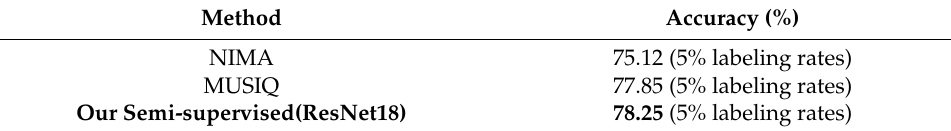
Table 7. Comparison with state-of-the-art methods on CUHK dataset.